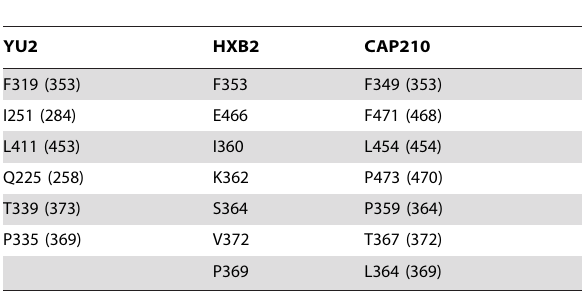
Table 1. The residues along the optimal path for communication in the three networks.